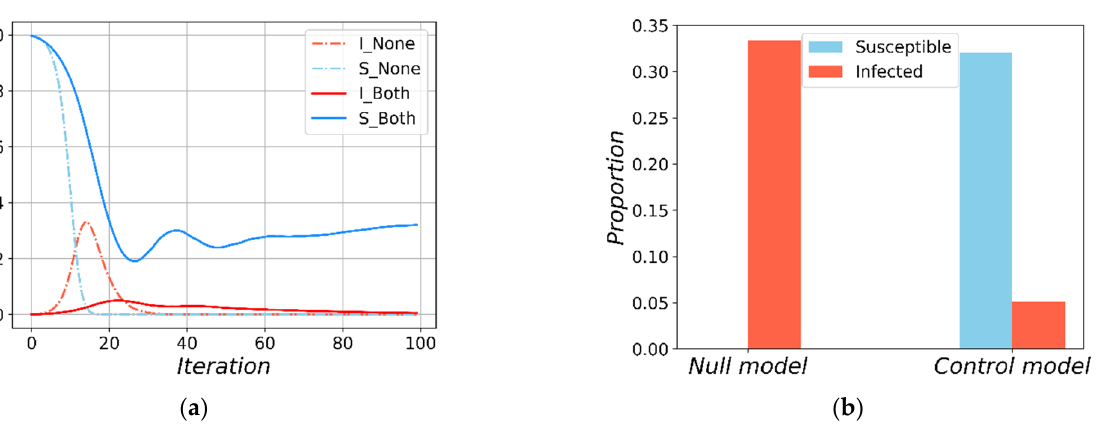
Figure 3. The results of the susceptible and the infected under no travel restrictions and under both local and global restrictions in the multi-regional-SQEIR model. In ( a ), the dashed-dotted lines represent simulations results with no travel restriction, the solid lines represent with both travel restrictions, the red lines represent the fraction of infected individuals, the blue lines represent the fraction of susceptible individuals. In ( b ), the steady state results of the susceptible and the peak results of the infected, the red bar represent the peak of infected individuals, the blue bar represent the steady state of susceptible individuals. ( a ) The transmission processes. ( b ) The steady and peak results.